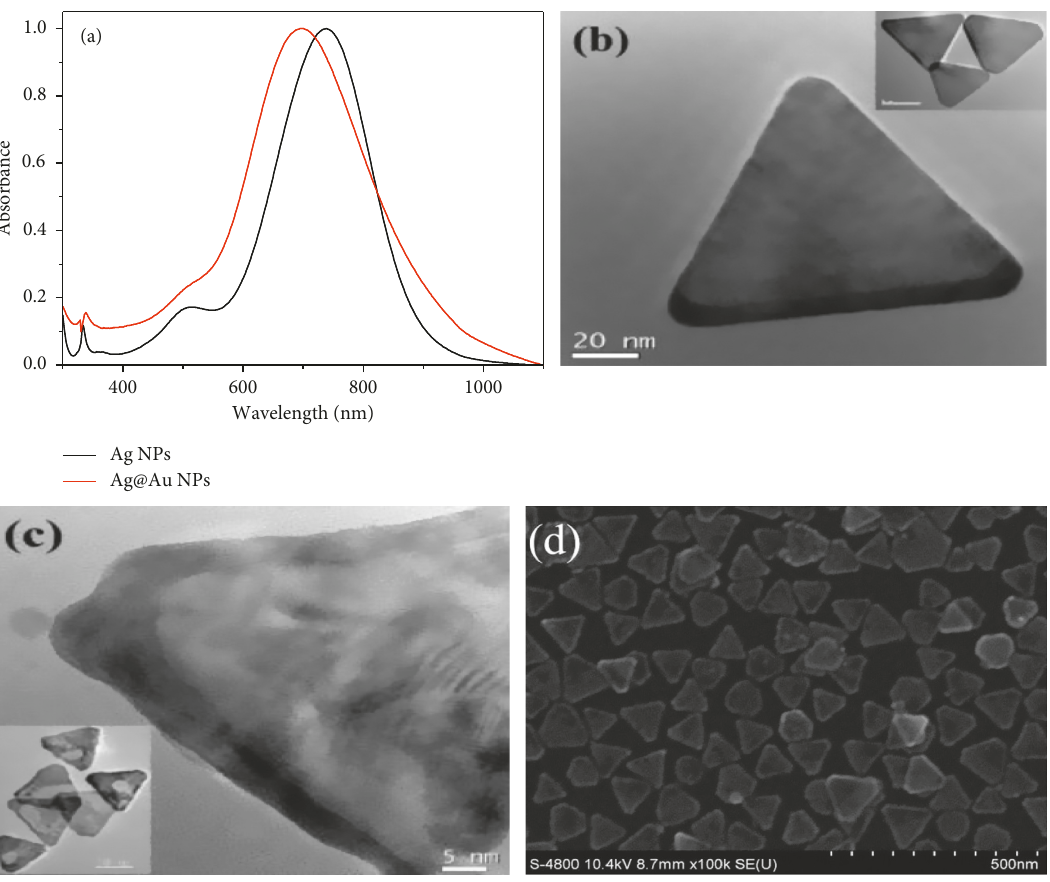
Figure 1: (a) UV-Vis extinction spectra of prepared triangular silver NPs (black line) and Ag@Au core-shell NPs (red line). (b) and (c) TEM images of triangular silver NPs and Ag@Au core-shell NPs. (d) A scanning electron microscopy image of Ag@Au core-shell